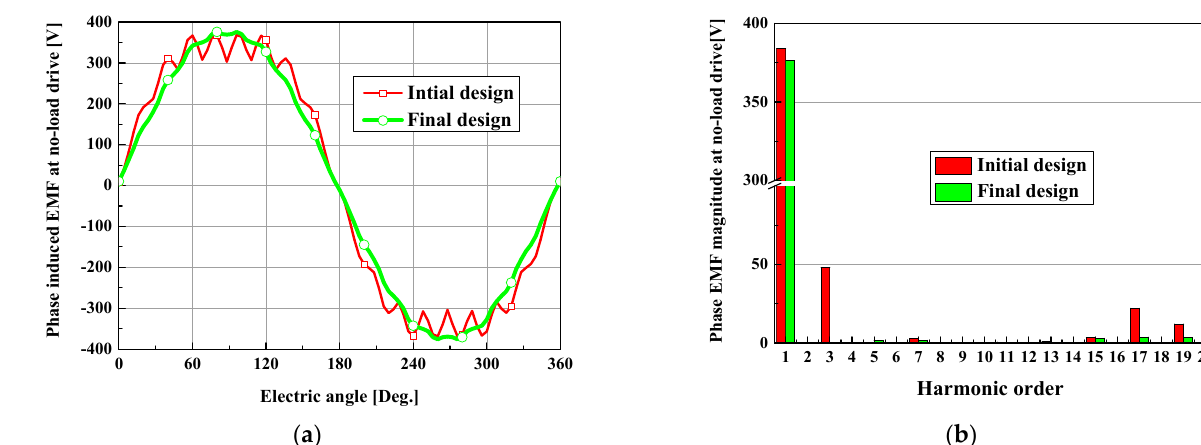
Figure 12. Comparison of the induced EMF at no-load and load drives for the initial and final design: ( a ) wave form, and ( b ) harmonic order.